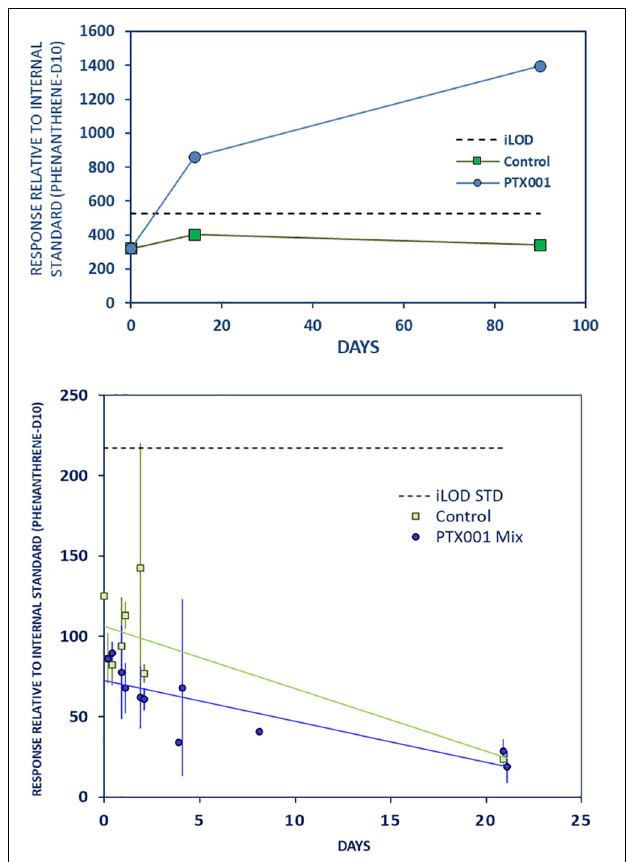
FIGURE 6 | Strong long-term leaching of DEHP from PTX001 to stomach oil. Further caption details as in Figure 2 .